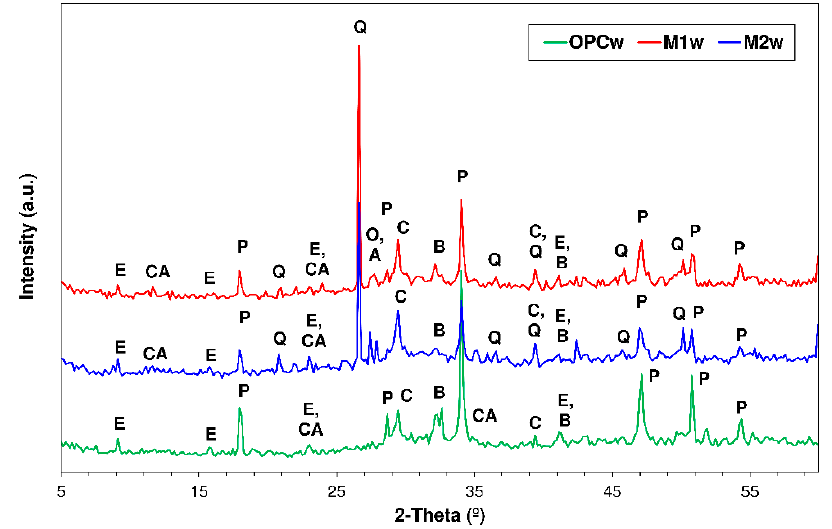
Figure 4. XRD patterns for 56-d-soaked pastes: OPC, M1 and M2 (Note—E: ettringite; CA: calcium monocarboaluminato; P: portlandite; Q: quartz; O: orthoclase; A: Albite; C: calcite; and B: belite).